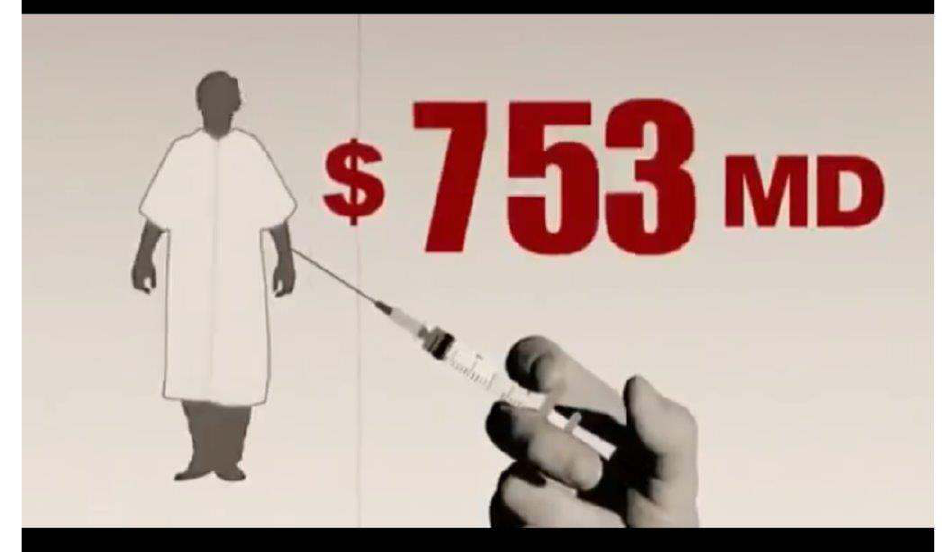
Source: Overdose, the Next Financial Crisis by Martin Borgs (screen